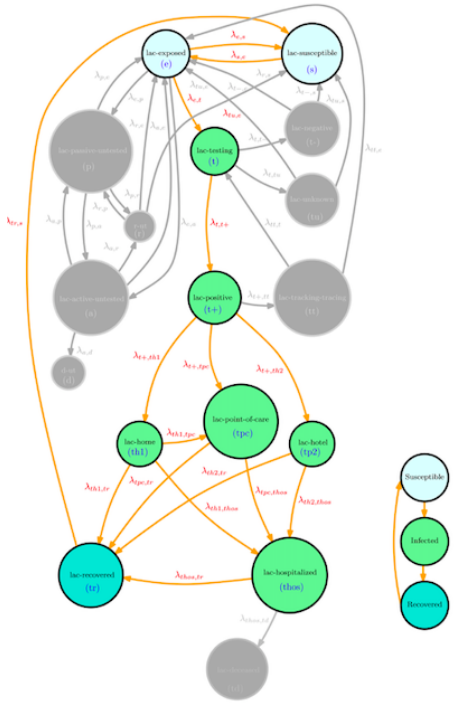
Figure 8. Connection of the dynamics of SIR.